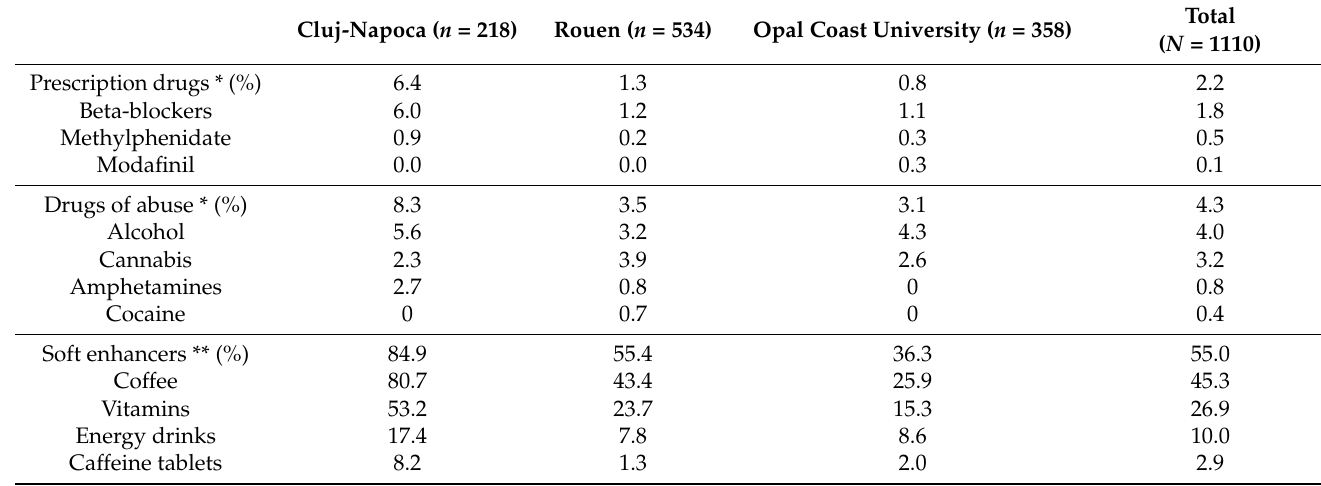
Table 2. Prevalence of neuroenhancement, by substance category and study site, over the last 12 months ( N = 1110).